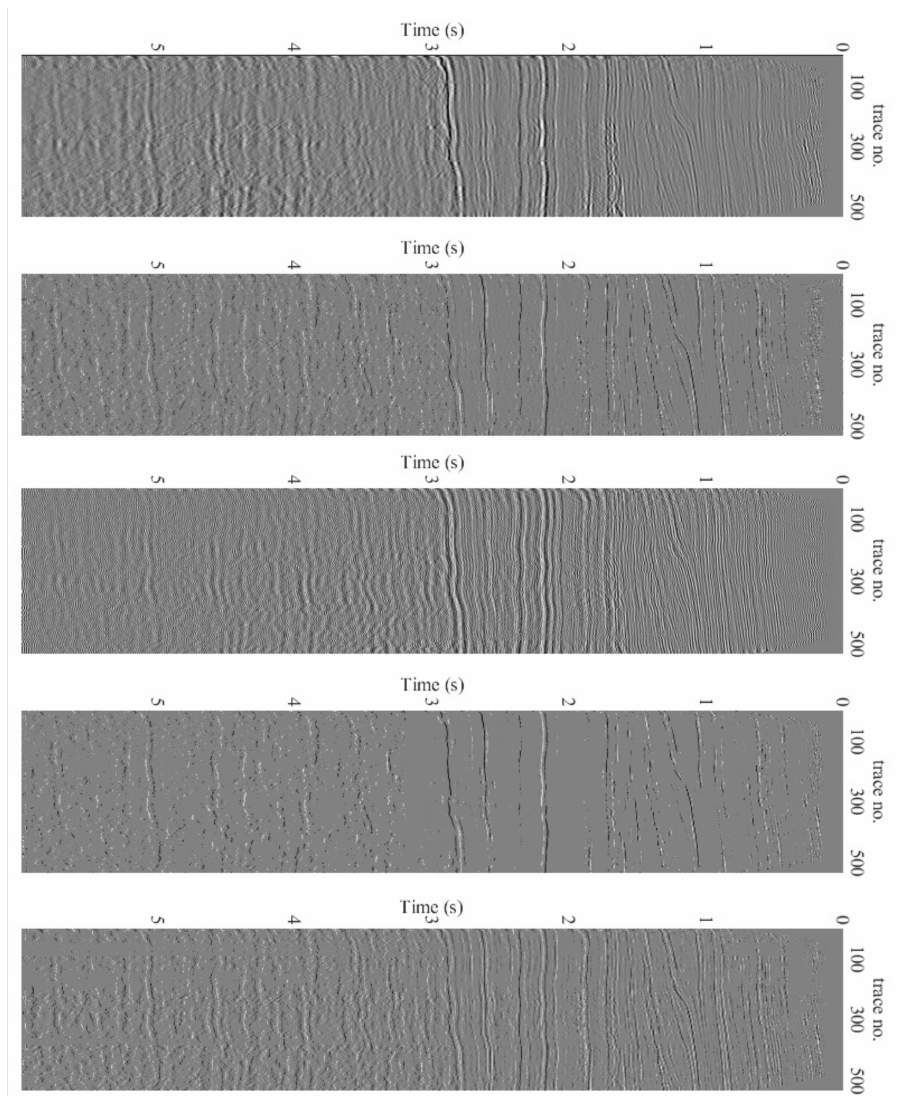
Figure 11. Deconvolution results for (Q = 0.8 Y). Top to bottom: Received data for 6s and 500 traces, BP method, SP method, Proposed (first iteration) and Proposed (last